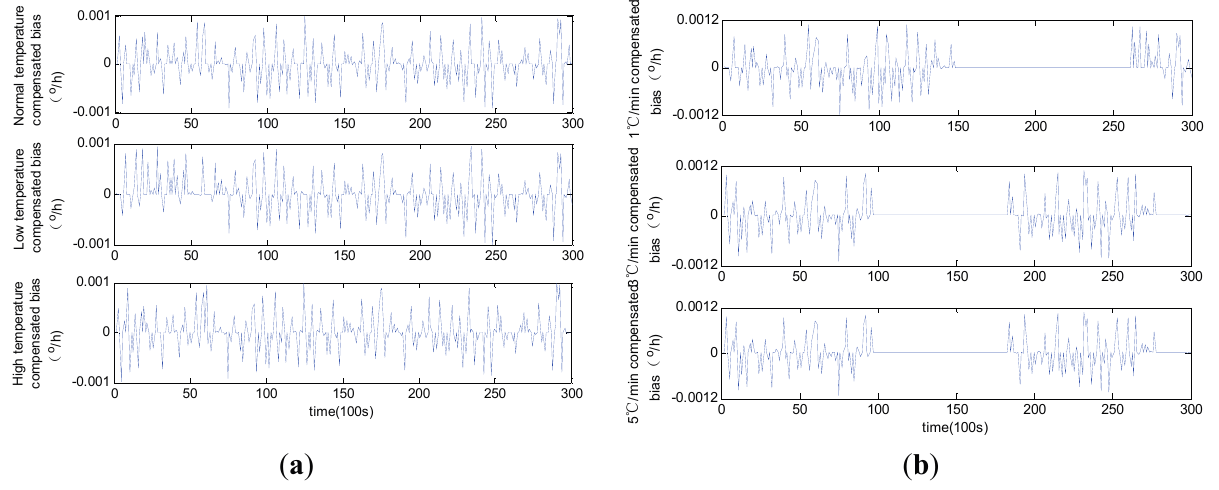
Figure 10. Compensated zero bias history using traditional RBFNN: ( a ) constant temperature; ( b ) variable temperature.